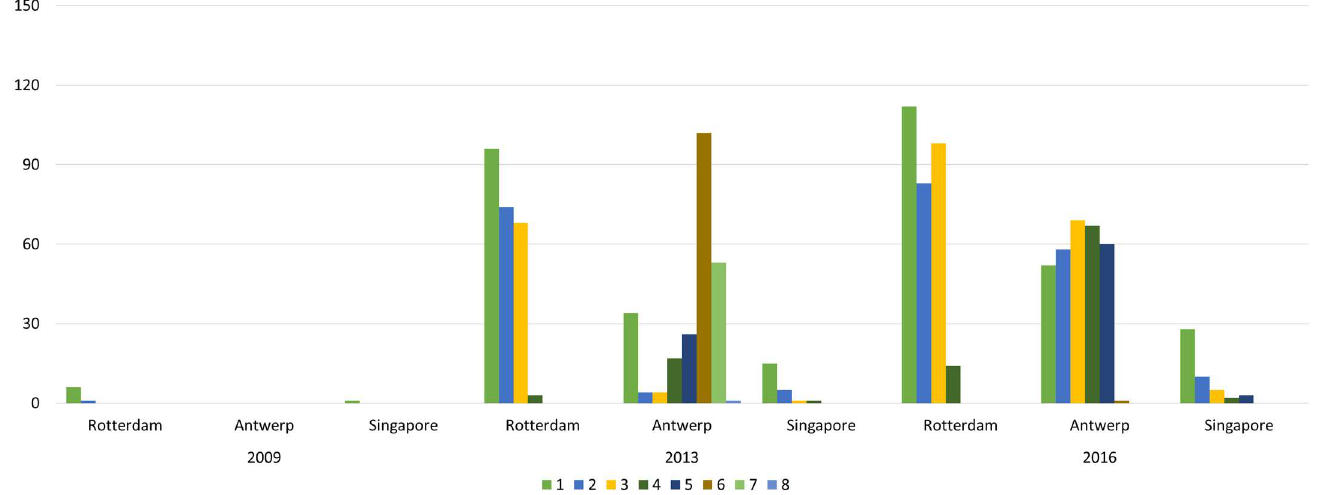
Figure 7. Number of influenced ports of influence at different diffusion stages: Rotterdam, Antwerp, and Singapore.